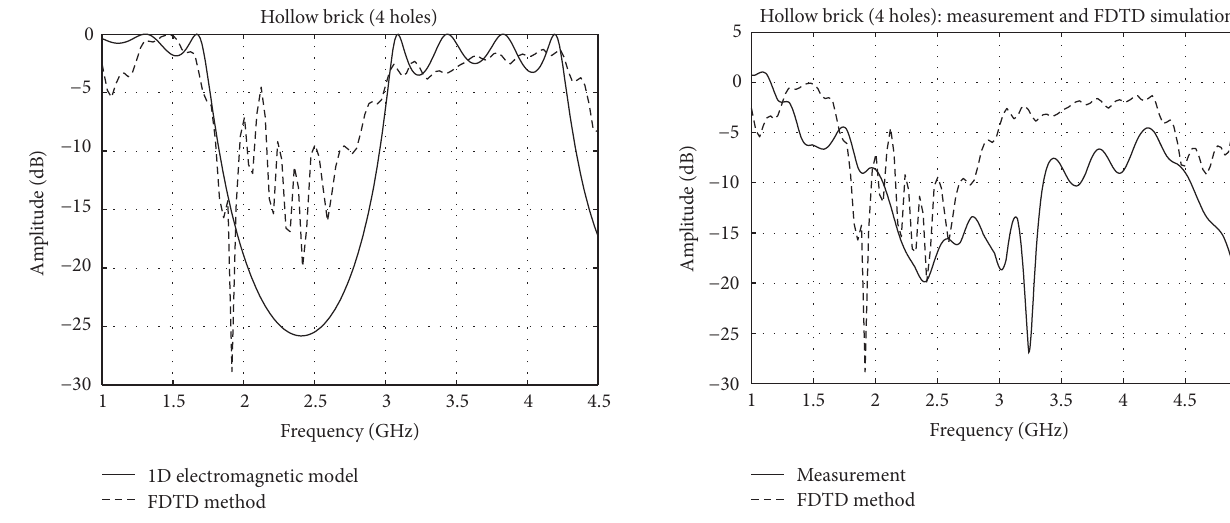
F 4: Comparison of transmission coefficient obtained by measurement (full line curve) and by simulation (dashed